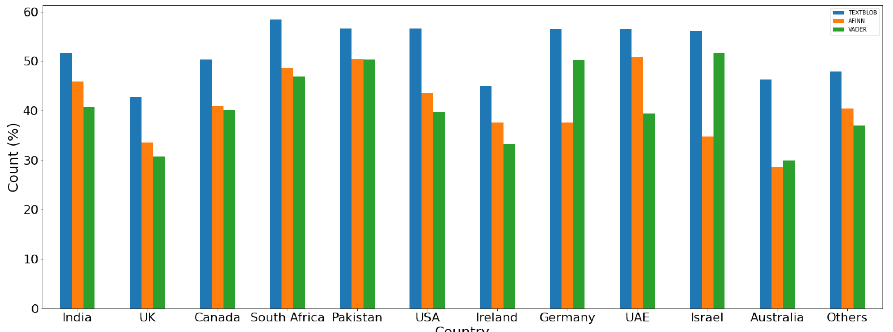
Figure 16. Neutral sentiment (%) using each lexicon-based